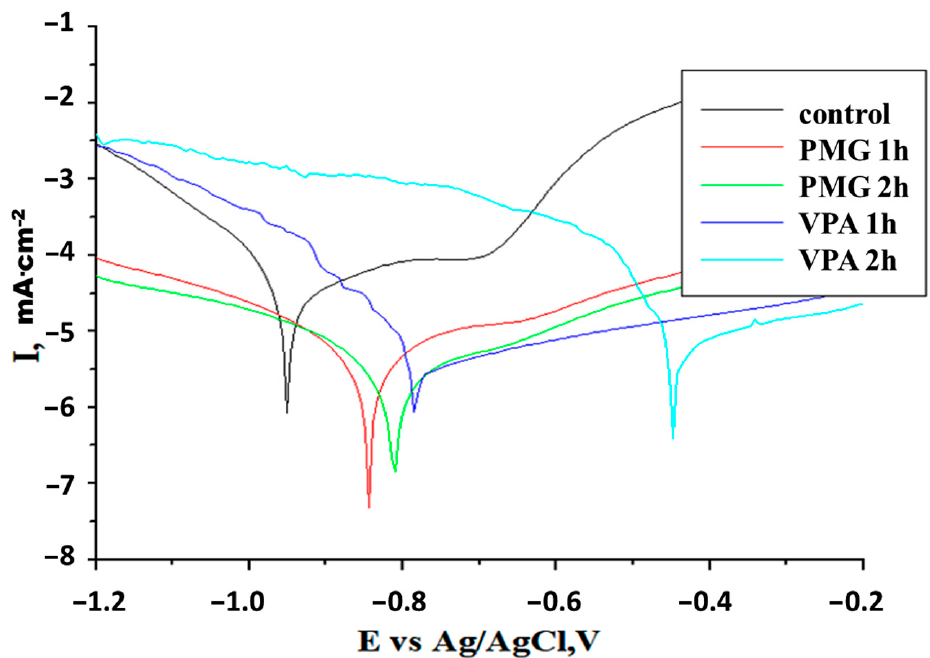
Figure 1. Potentiodynamic polarization curves for carbon steel after different immersion times in 3% NaCl solutions, pH = 2.3 without (control) and with 2 mM inhibitor (scan rate = 1 mV/s), at 22 ◦